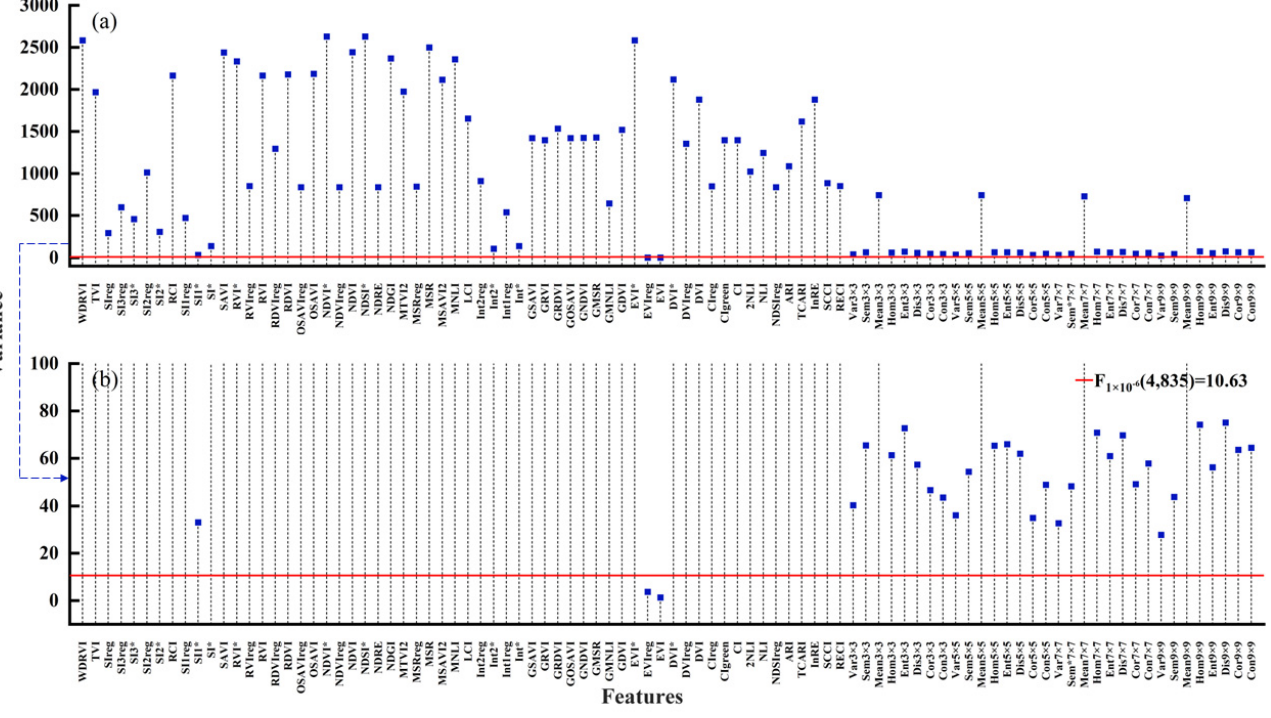
Figure 4. Vegetation index and variance of texture characteristics: ( a ) all characteristic variance values and ( b ) characteristics with variance values less than 100.